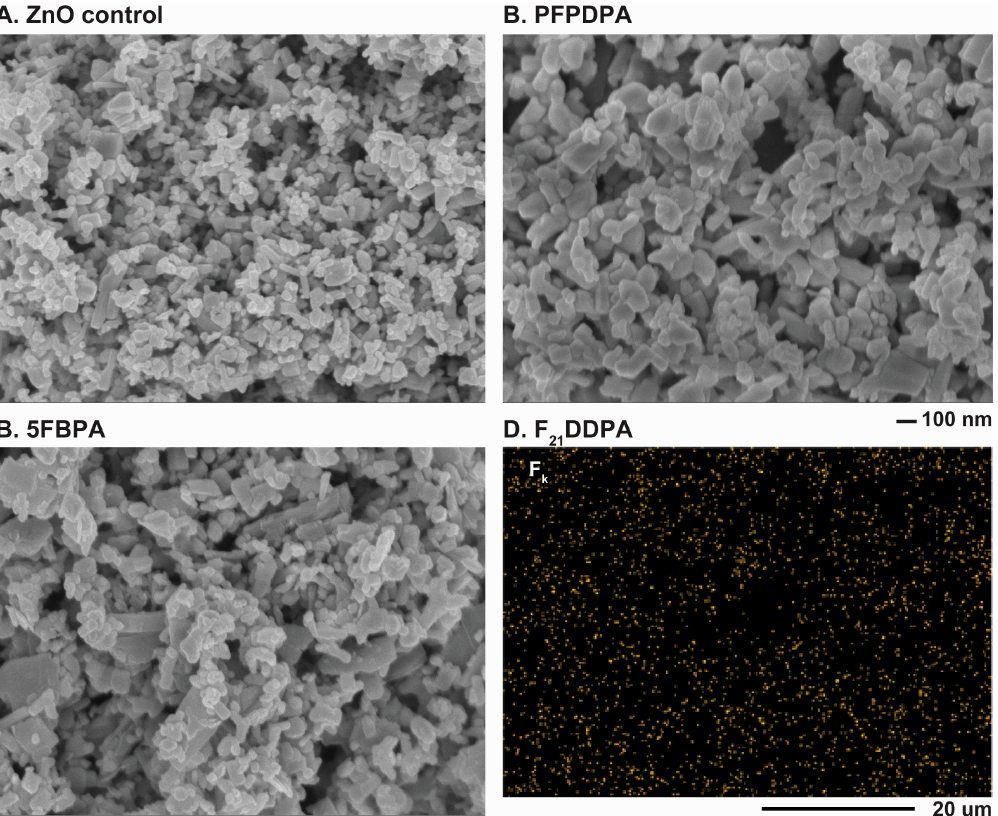
Figure 5. SEM survey spectra of ( A ) ZnO nanoparticles unmodified (control); ( B ) PFPDPA on ZnO; ( C ) 5FBPA on ZnO; and ( D ) energy dispersive X-ray spectroscopy (EDS) fluorine (F k ) elemental mapping pattern for F 21 DDPA on ZnO nanoparticles.